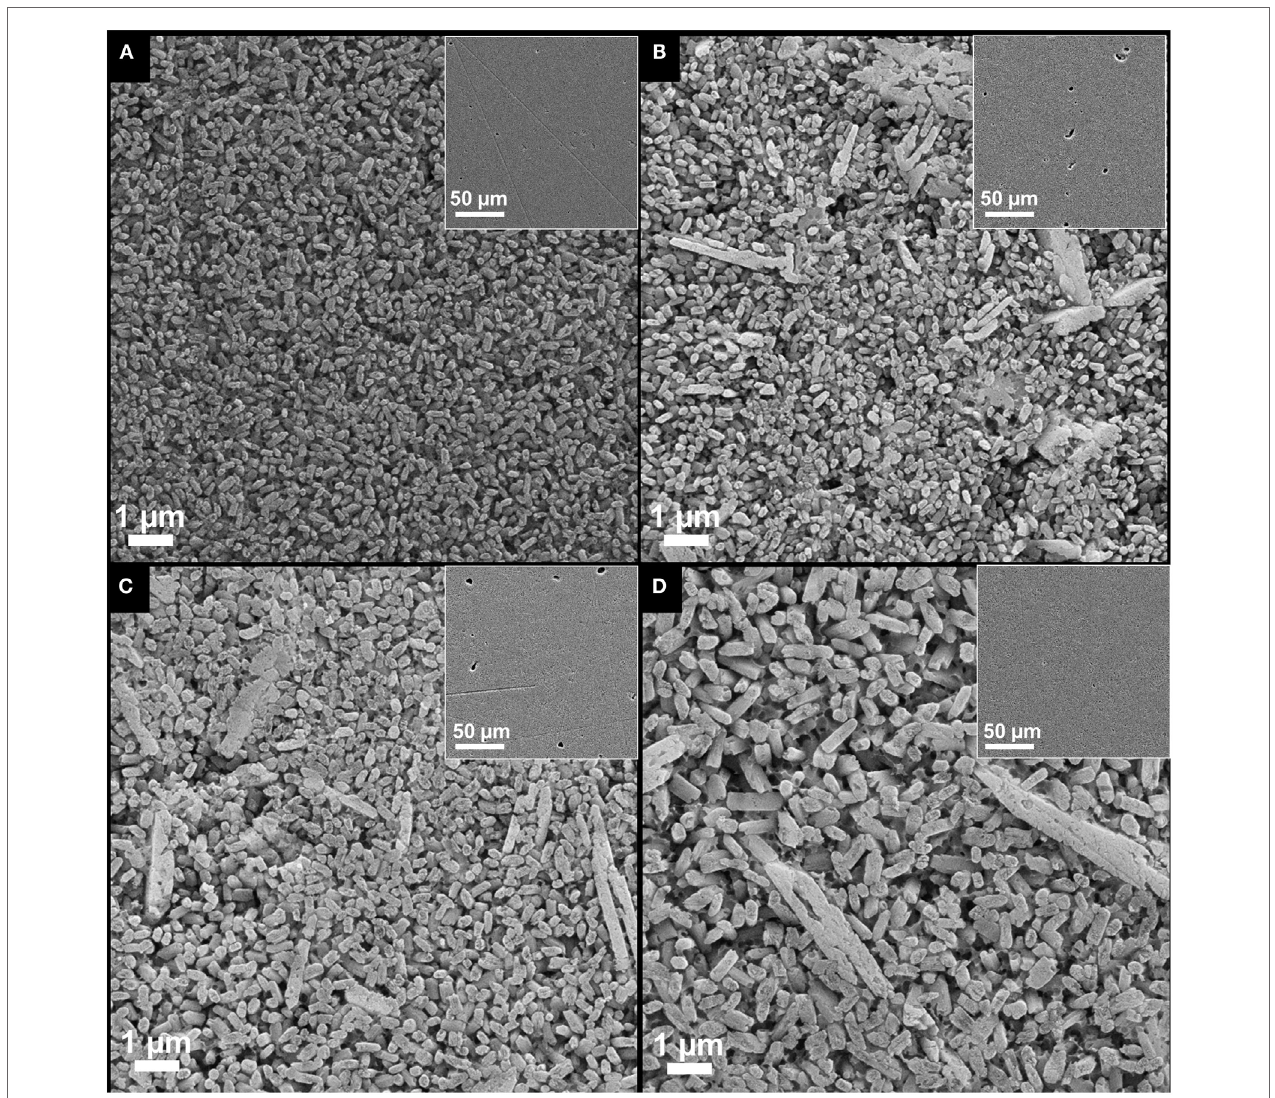
FigUre 6 | Micrographs of the glass-ceramics (a–D) after sintering at 860°c for 5 min